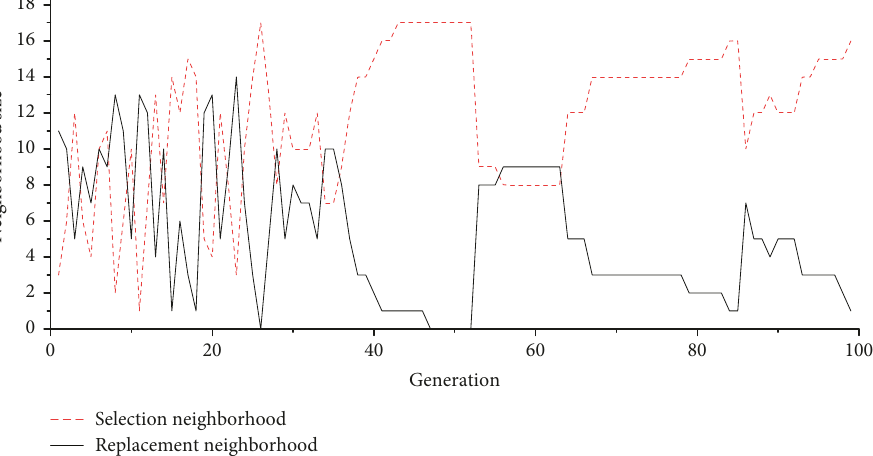
Figure 8: Variation of neighborhood sizes of the 96th